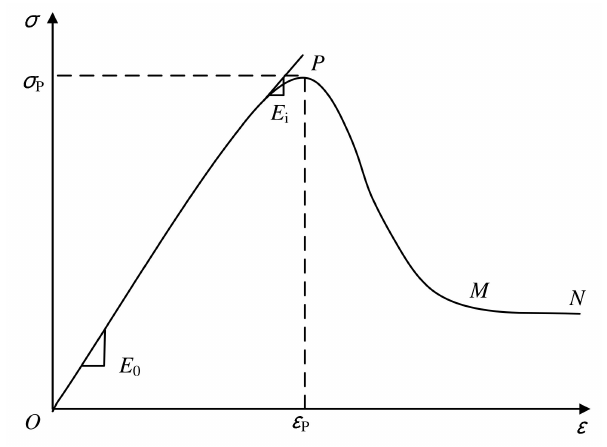
Figure 4. Axial stress–strain